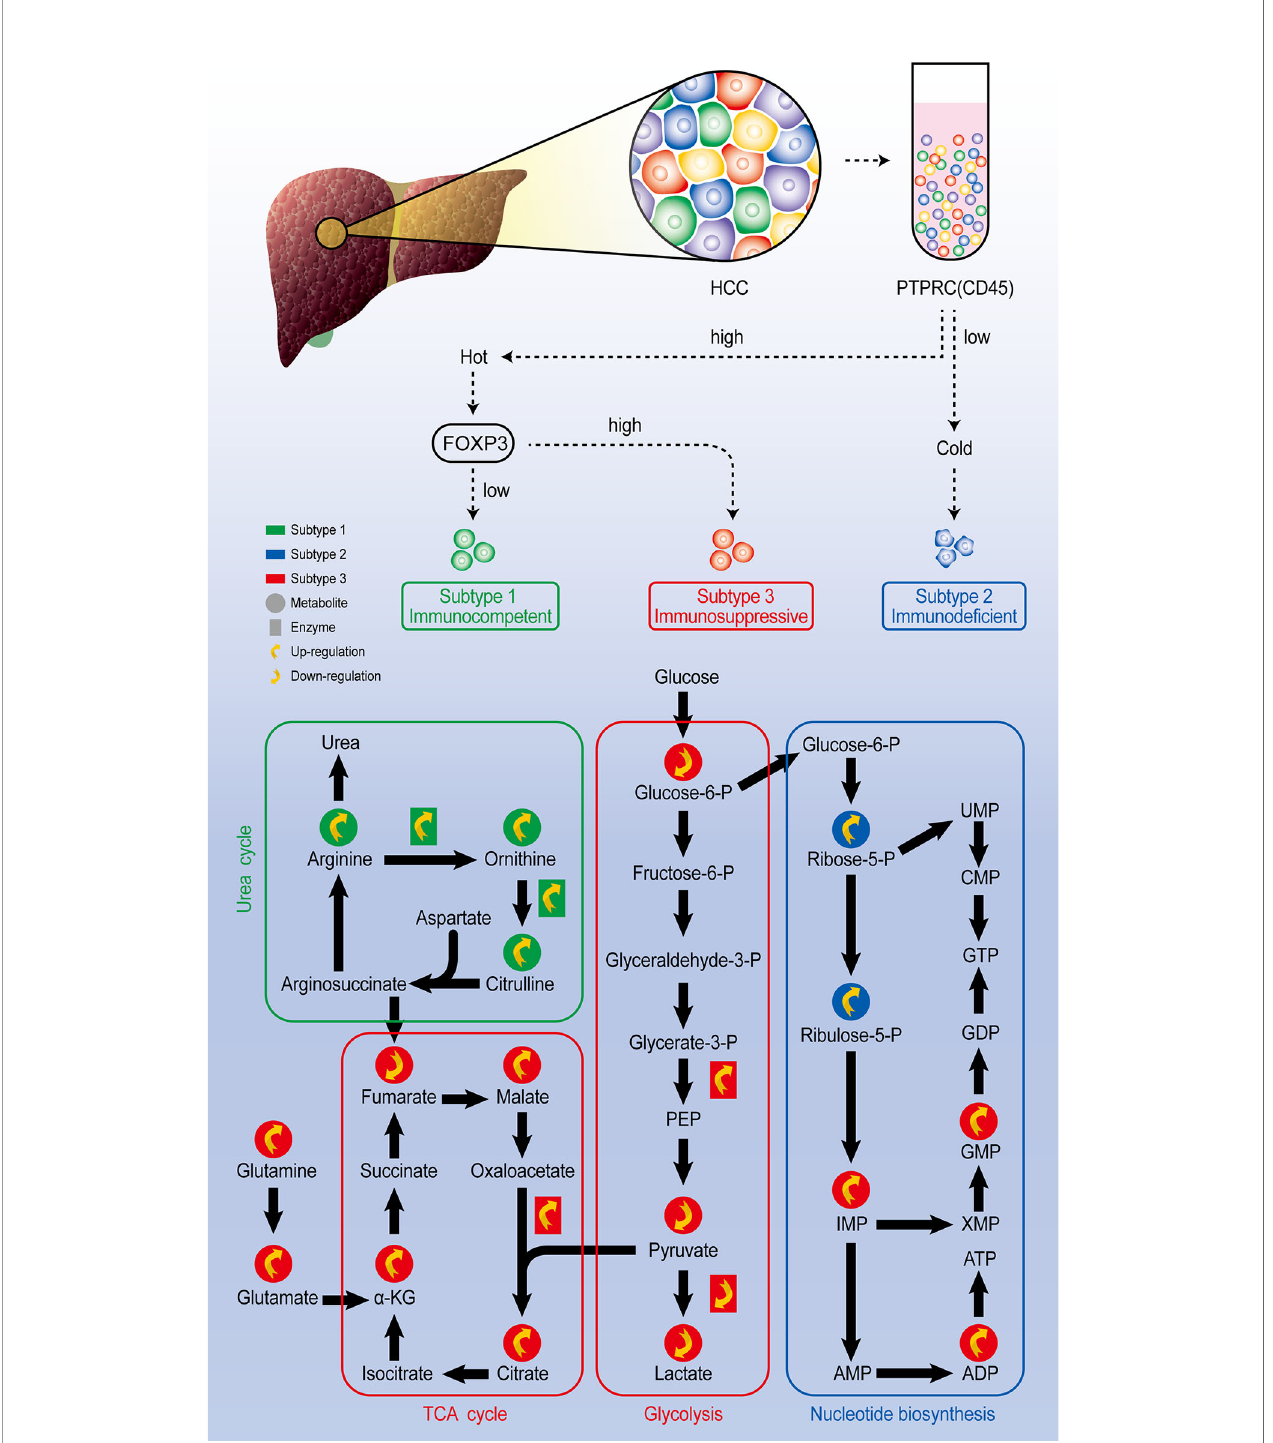
FIGURE 4 | Comprehensive exploration of the heterogeneity of HCC analysis scheme. Through single-cell sequencing, HCC could be classi fi ed as three subtypes according to the expression level of marker genes PTPRC and FOXP3. Further single-cell metabolomic analysis revealed that the immunocompetent subtype is with upregulated urea cycle, the immunosuppressive subtype is with upregulated TCA cycle and inhibited glycolysis pathway, and the immunode fi cient subtype presents upregulated nucleotide biosynthesis pathway.